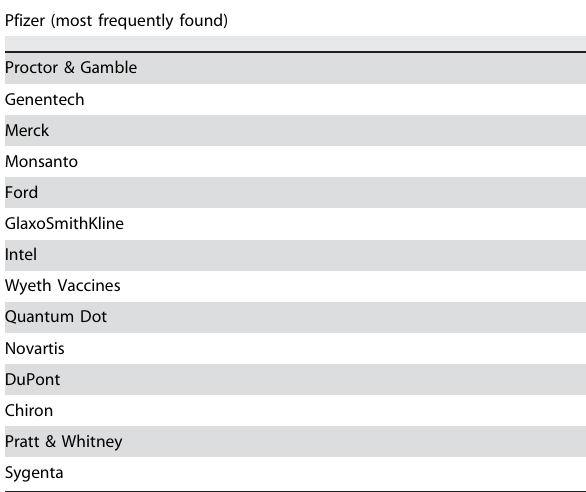
Newspaper/Source